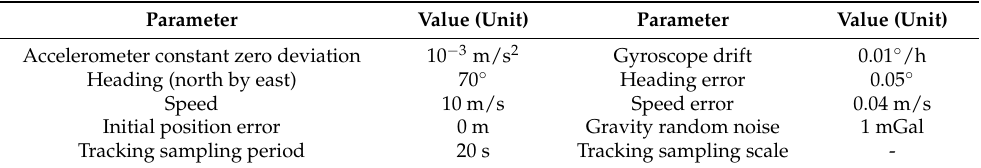
Figure 4. Illustration of ( a ) satellite remote sensing graph and ( b ) gravity reference map for the selected studied region. Table 1. The setting of other simulation parameters in experiments.